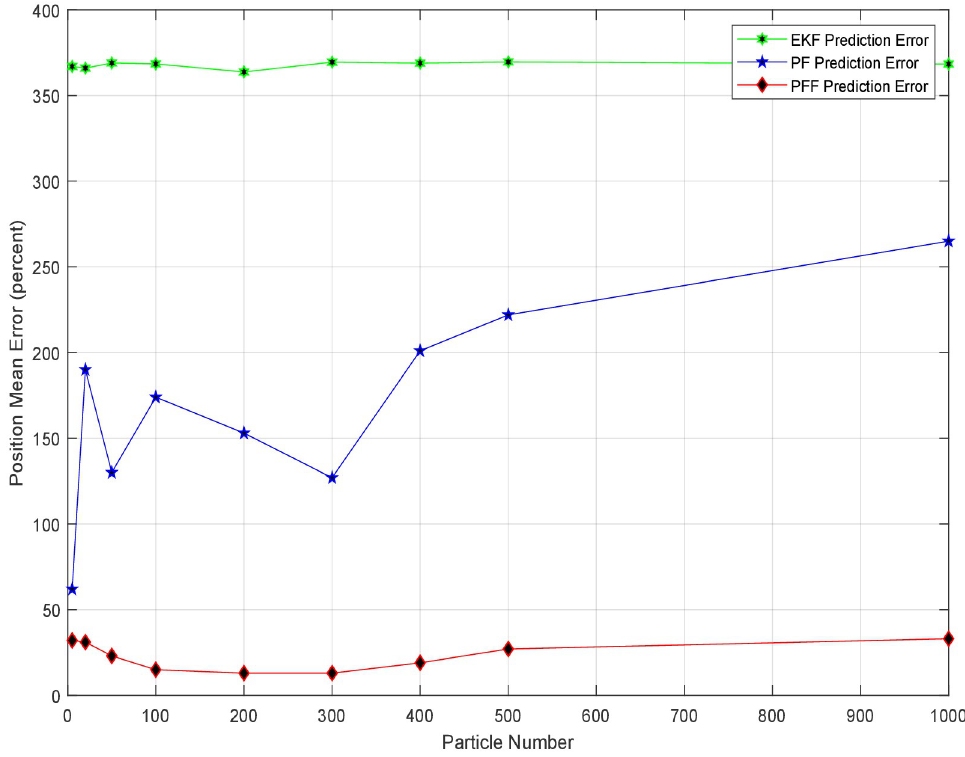
Fig 14. PFF-A-SLAM algorithm estimation error versus particle